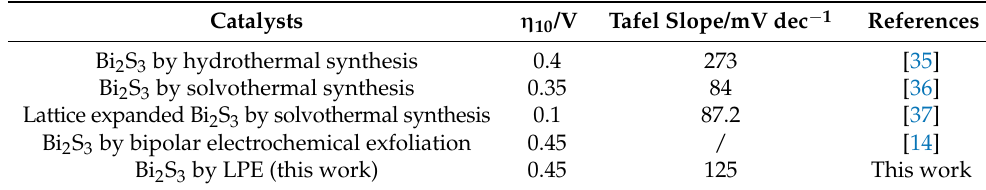
Table 1. Comparison of electrocatalytic HER performance for different Bi 2 S 3 electrocatalysts.